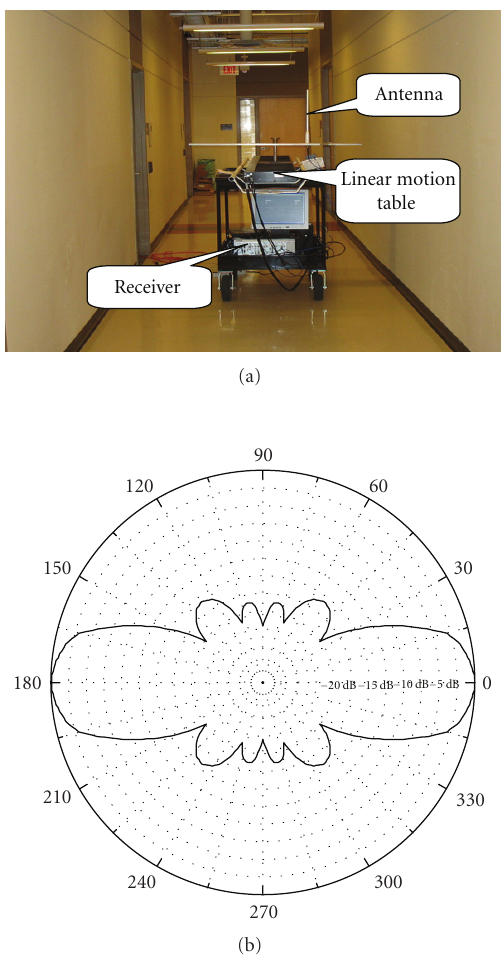
Figure 7: (a) Data collection environment and measurement equipment. (b) Vertical pattern of the